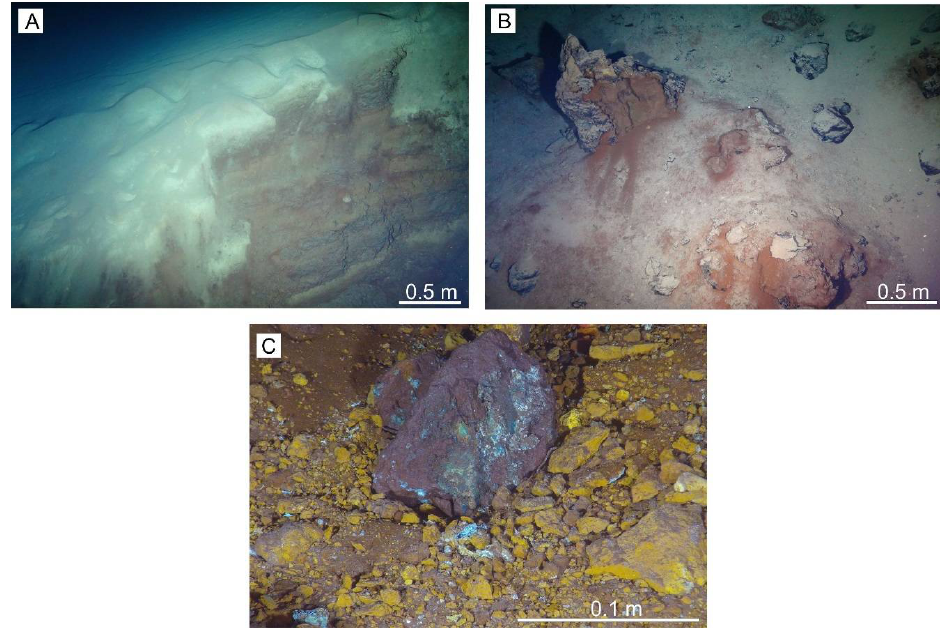
Figure 3. Photographs of seafloor features observed at extinct seafloor massive sulfides (eSMS) sites in the Trans-Atlantic Geotraverse (TAG) hydrothermal area. ( A ) Pelagic sediment underlain by reddish-brown hydrothermal sediment in a fault scarp at Southern Mound, 45HyBIS. ( B ) Upright relict chimney on top of New Mound #2, 55HyBIS. ( C ) Sulfide talus coated by copper-chloride (greenish), jarosite (yellowish-brown) and iron-oxyhydroxide (reddish-brown) at Southern Mound,